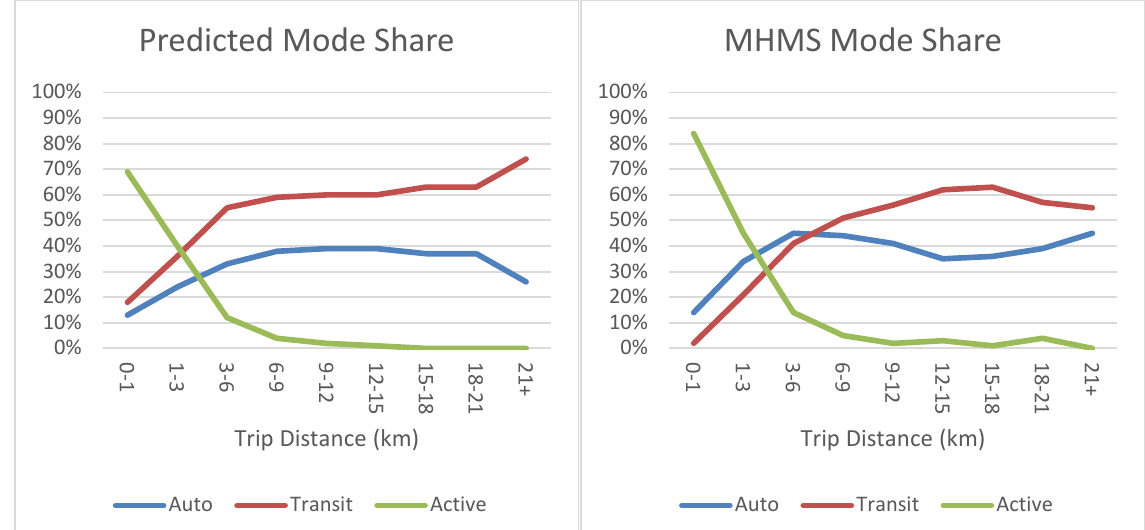
Figure 3. Predicted and Observed Mode Shares by Trip Distance